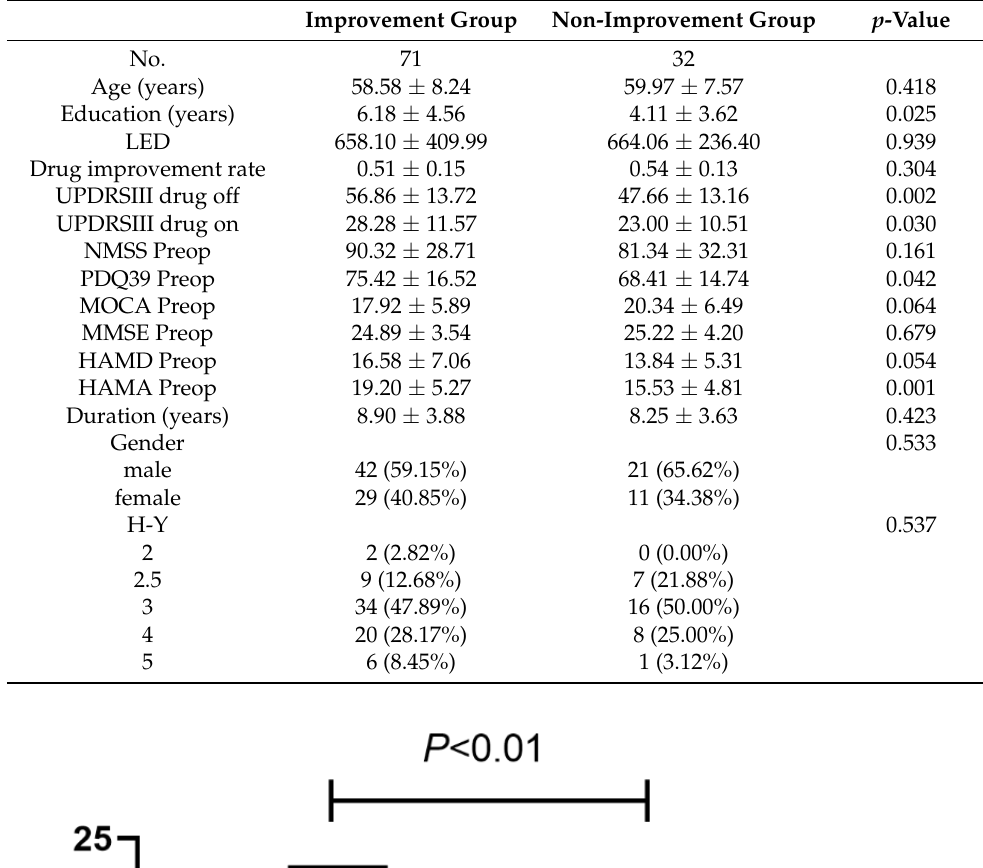
Table 1. Comparison between patients with and without improved anxiety after STN-DBS.